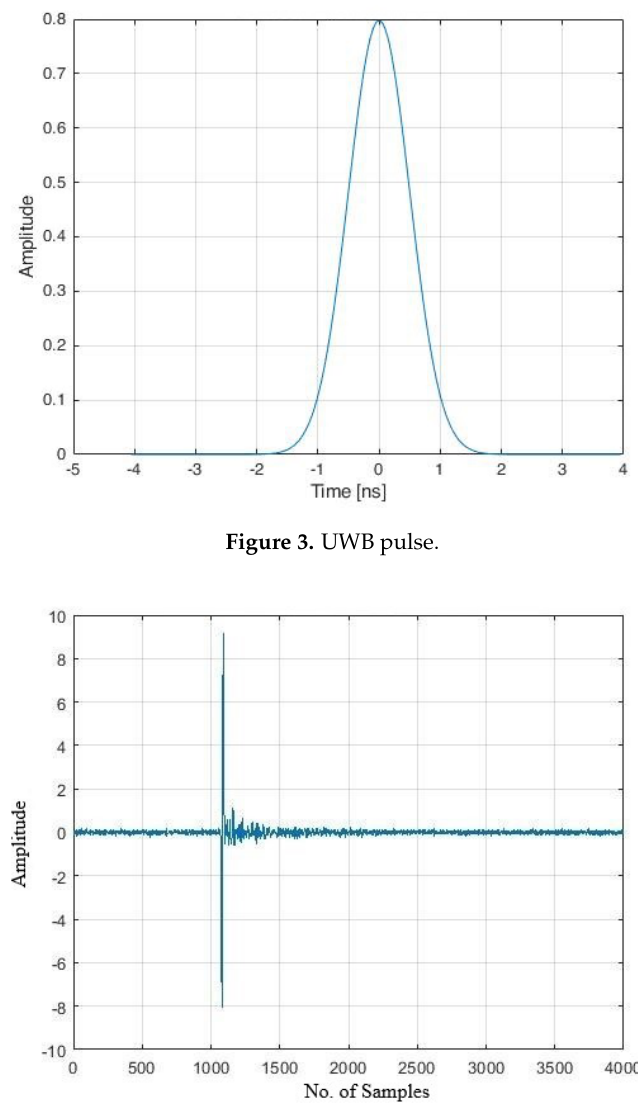
Figure 4. Correlated output